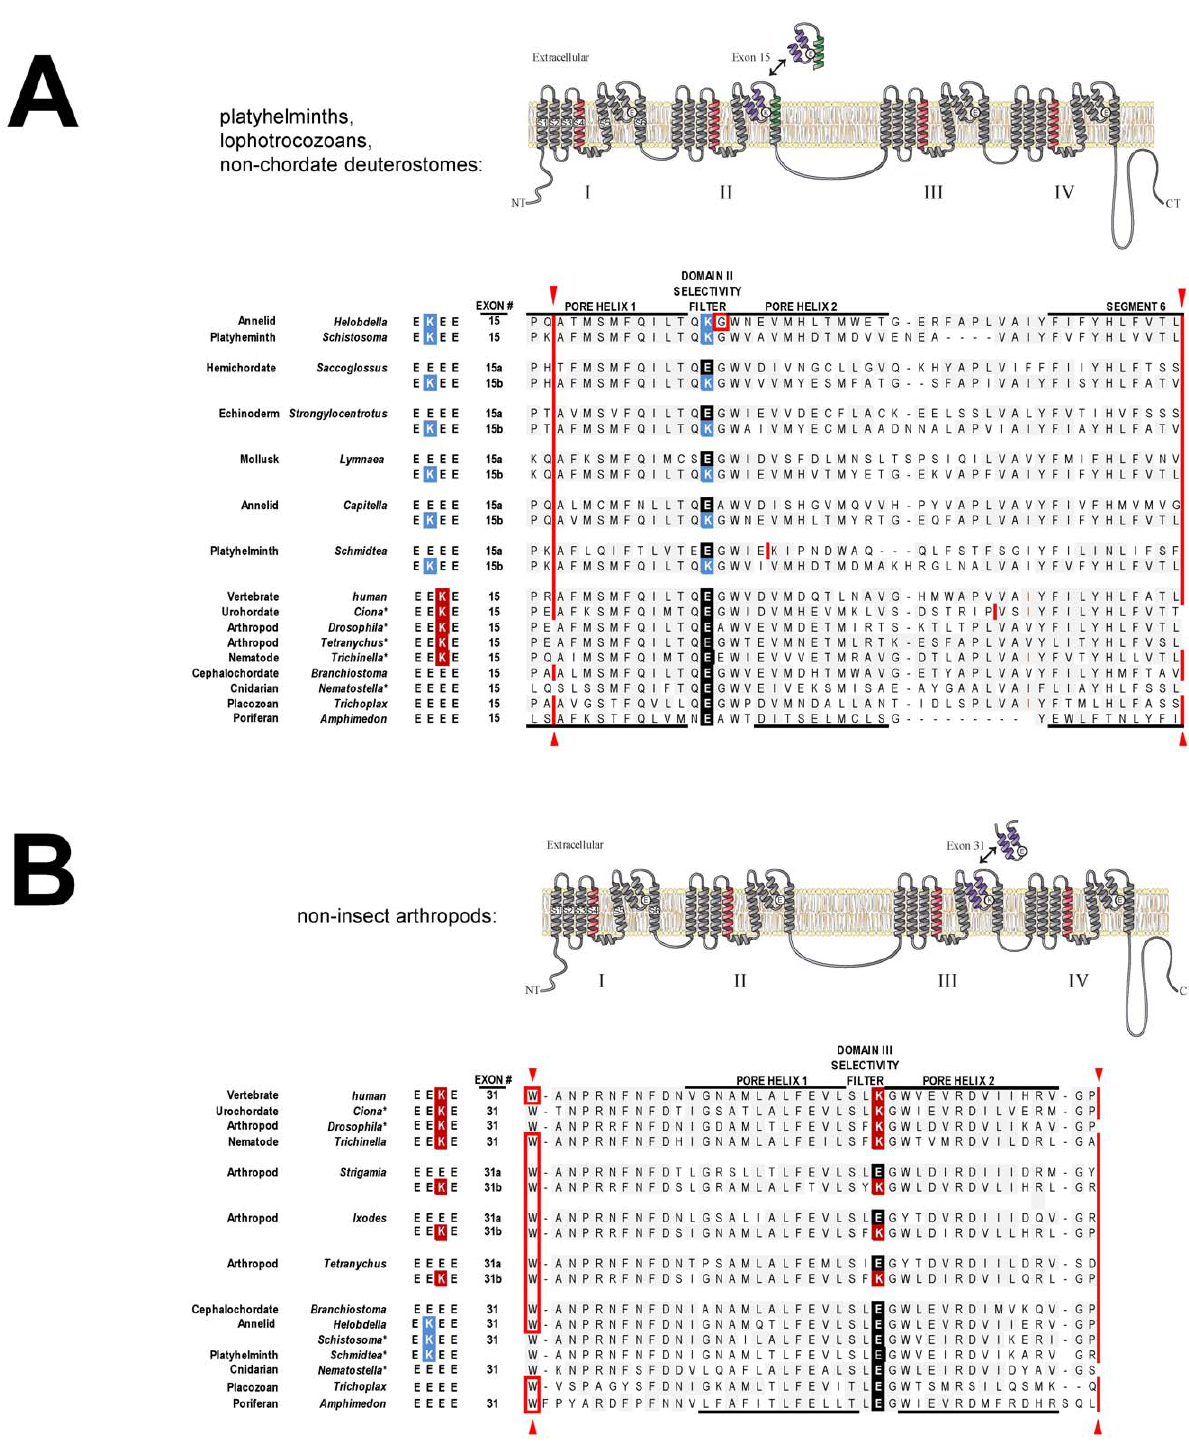
Figure 2. Representative NALCN sequences of alternative calcium- and sodium-selective pores generated by alternative exons (A) exon 15 (EEEE/EKEE) and (B) exon 31 (EEEE/EEKE). Exons 15 and exon 31 (delimited by splice junctions shown in red), span the re-entrant P- loop (pore helices surrounding the selectivity filter) in Domains II and III, respectively. Exon 15 also includes the proximate region of segment 6, while exon 31 includes the distal portion of the extracellular turret. Splice junctions for exons 15 and exon 31 are conserved in the earliest metazoans (sponge, placozoans), which are duplicated in most invertebrate phyla to produce tandem mutually-exclusive exons where the 5 9 exon codes for exon ‘a’ with E in the selectivity filter (15a, 31a) and the 3 9 exon codes for exon ‘b’ with K in the selectivity filter (15b, 31b). Either the donor or acceptor site of exon 15 or 31 are lost in most species outside chordates (indicated by *) that don’t have alternative-splice junctions to generate both calcium and sodium selective pores. Exons 15a/15b have variable sequence between the pore and segment 6 for generating a gene tree ( see Figure 4 ).